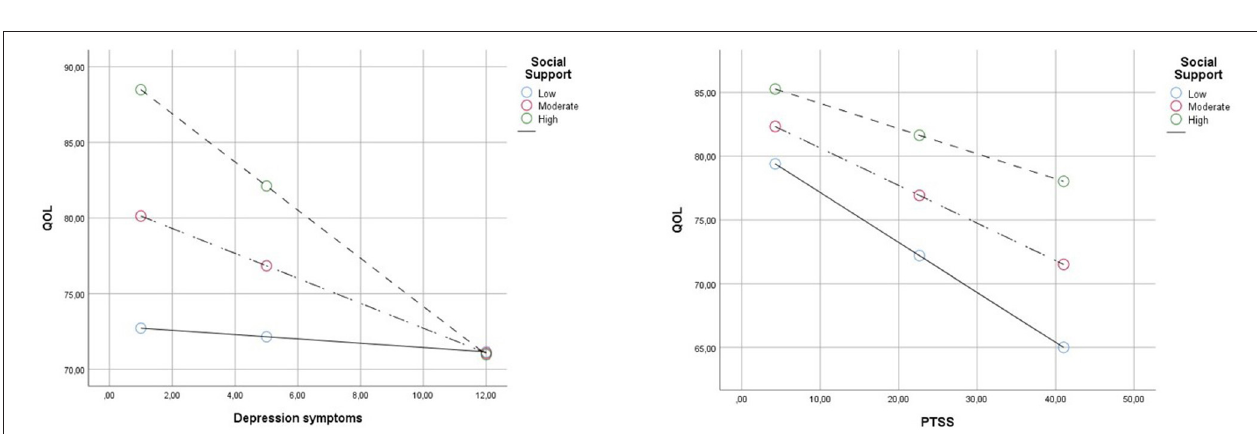
FIGURE 2 | Simple slopes representing the relationship between PTSS/Depression Symptoms and QOL scores at − 1 SD, mean, and + 1 SD values of social support scores.